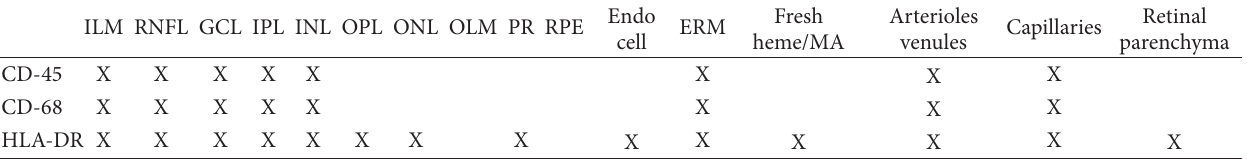
Table 3: Distribution of microglia in background diabetic retinopathy [64].